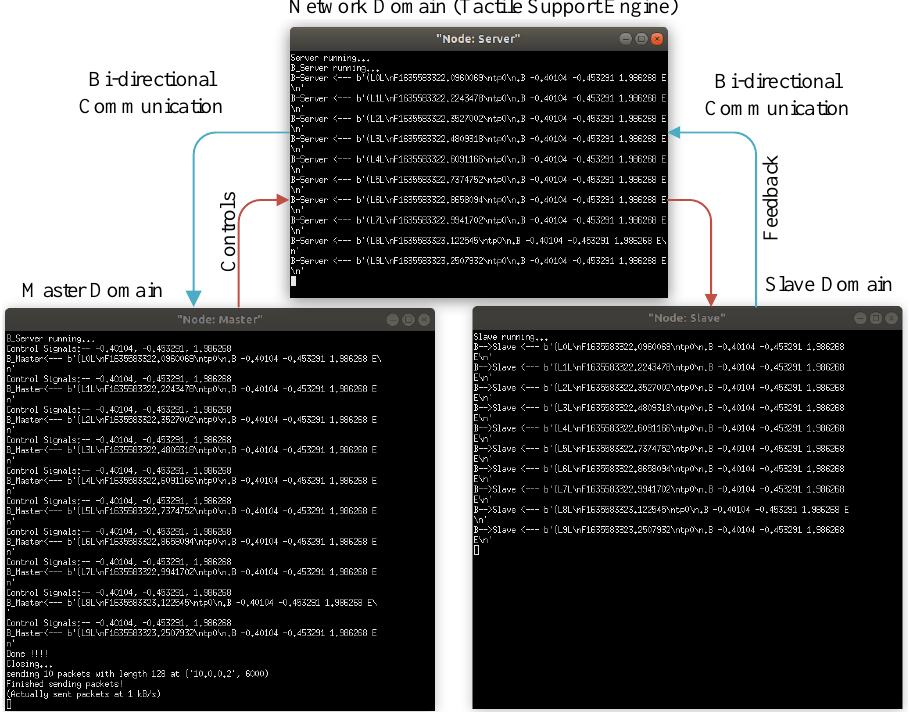
Figure 8. IoTactileSim interface for scenario I experiment.